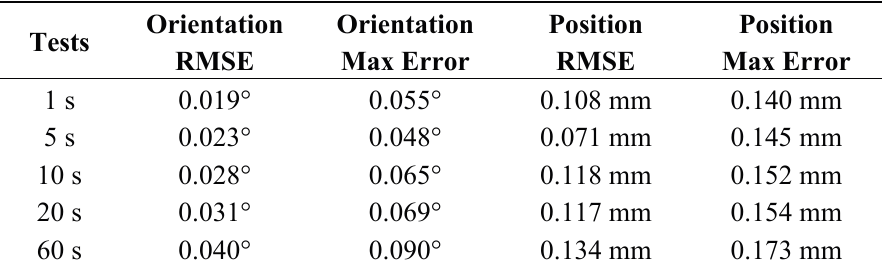
Table 2. Hybrid Tracker performance under partial occlusion condition.